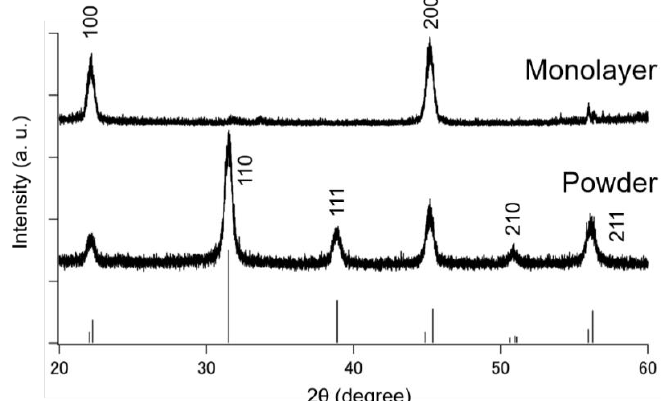
Figure 3. X-ray diffraction (XRD) patterns of BT nanocube monolayer with an area of about 0.3 cm 2 on a silicon substrate and BT nanocube powder. The vertical lines represent the diffraction pattern of tetragonal BT (P4mm).